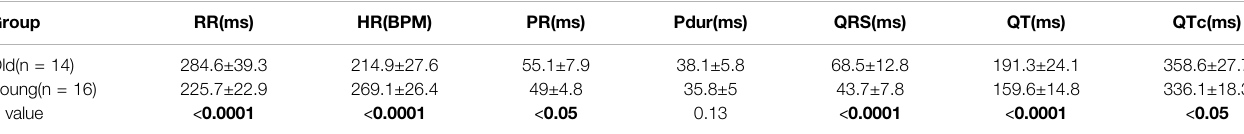
TABLE 4 | Age-dependent effects on ECG parameters using PES-AN approach.